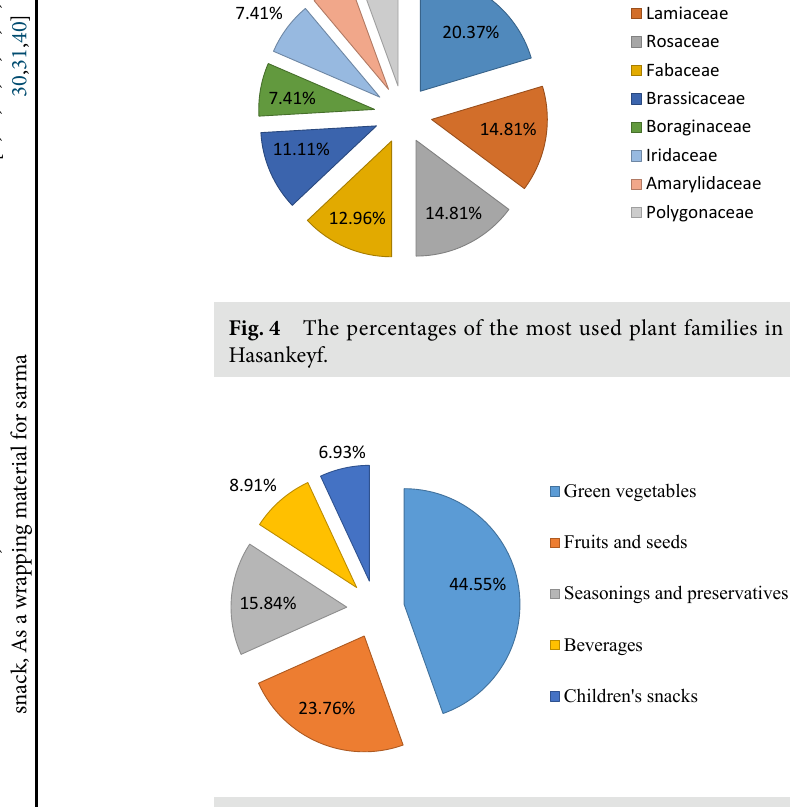
Fig. 5 The percentages of wild edible plants in various use